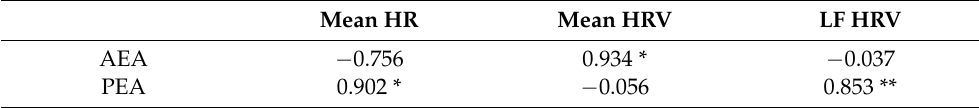
Table 4. Correlations between time and frequency domain of HRV and ligands of eCB. Mean HR Mean HRV LF HRV AEA − 0.756 0.934 * − 0.037 PEA 0.902 * − 0.056 0.853 **